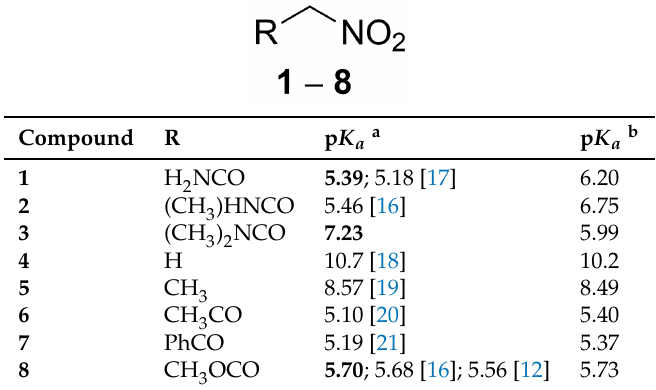
Table 1. Apparent ionization constants of primary nitro